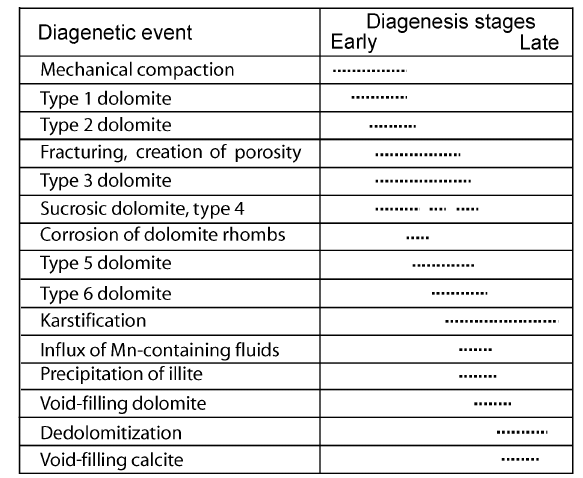
Fig. 15. Suggested paragenetic sequence of the Plavinas rocks in the study